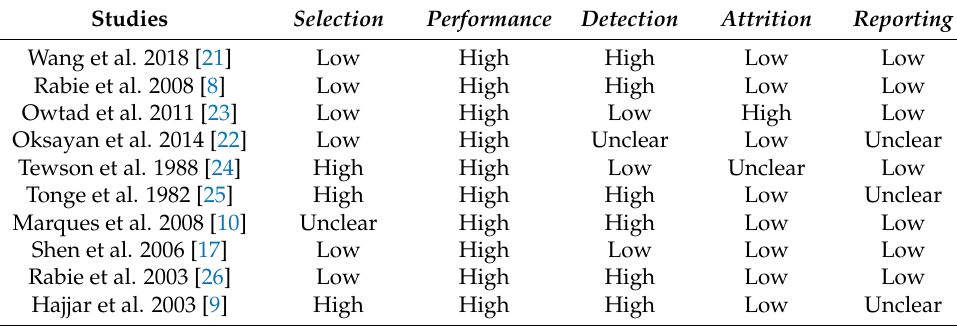
Table 3. Risk of bias. Each study was assessed according to signaling questions: Was the sample randomly selected? Was the experiment procedure blinded? Was the result assessment blinded? Did any data go missing during or at the end of the experiment from any group? Is there a reporting bias? Studies Selection Performance Detection Attrition Reporting Wang et al. 2018 [21] Low High High Low Low Rabie et al. 2008 [8] Low High High Low Low Owtad et al. 2011 [23] Low High Low High